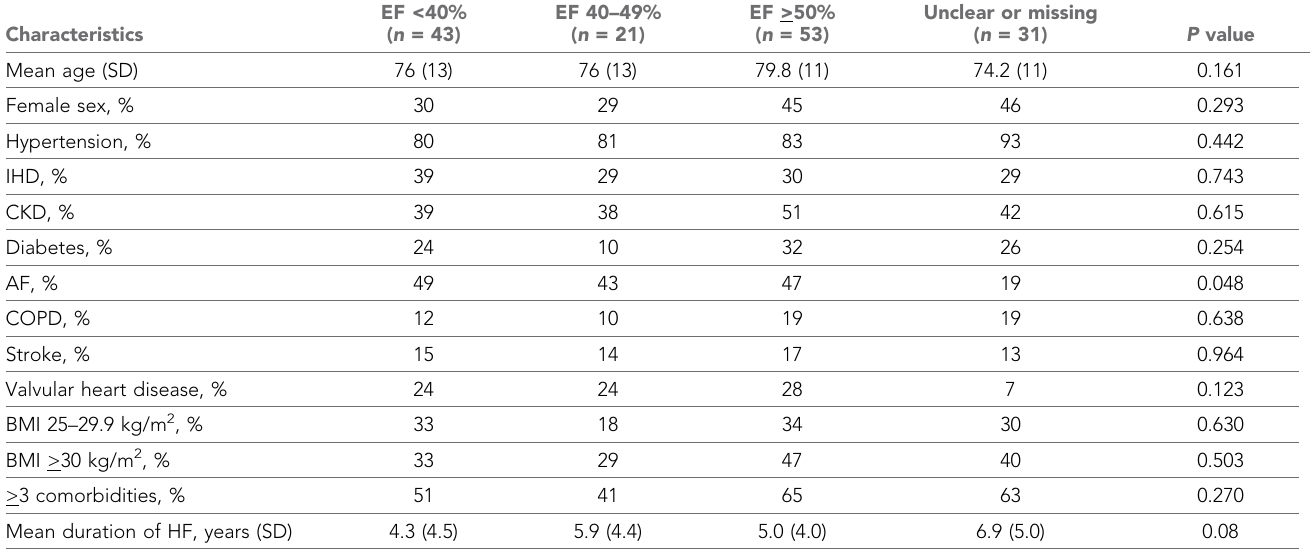
Table 2. Clinical characteristics by EF group